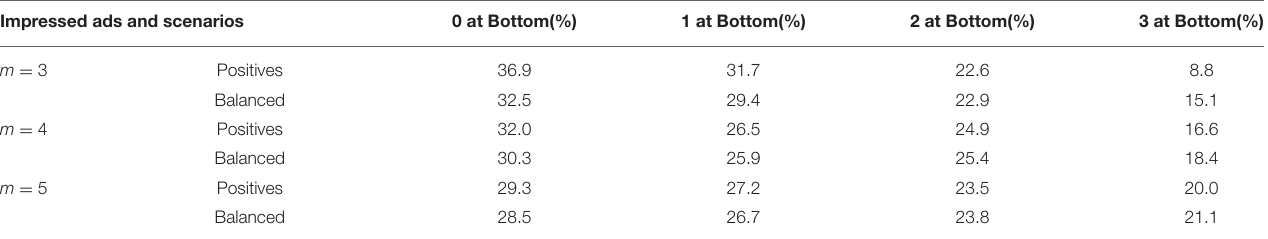
TABLE 3 | Observed frequencies of allocations.